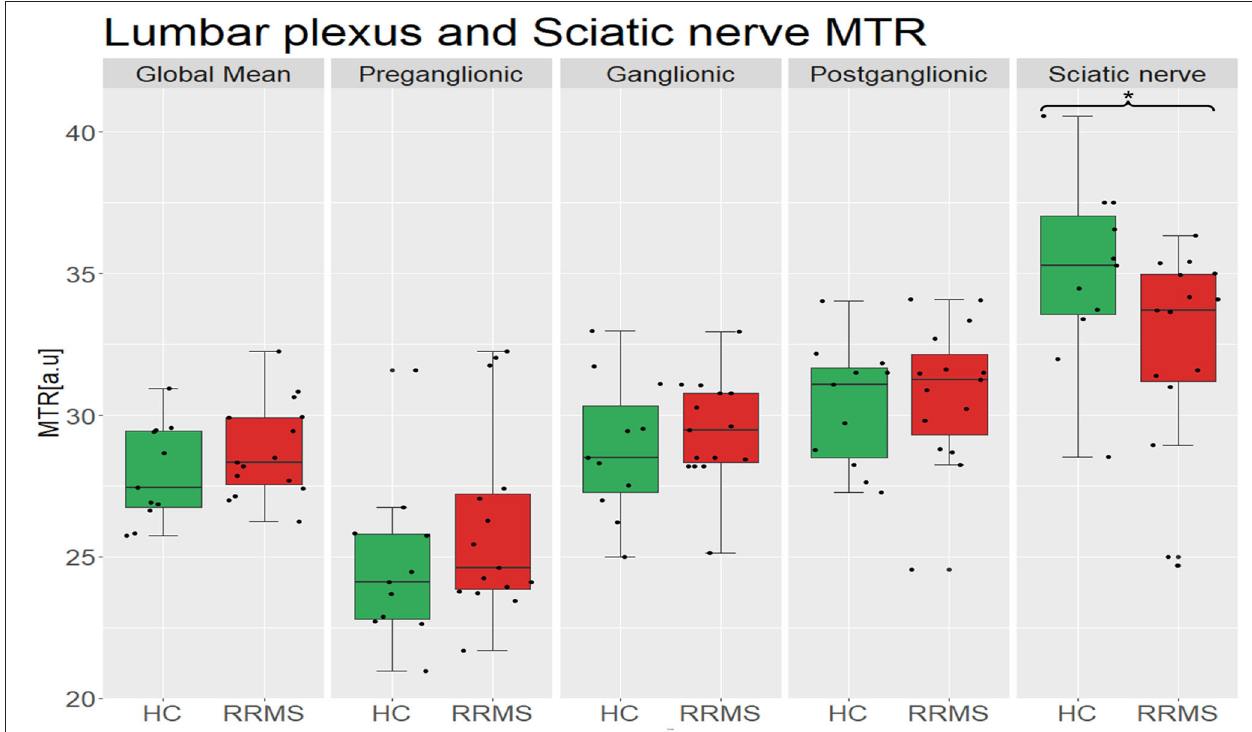
FIGURE 3 | Distribution of MTR values in the lumbar plexus (all lumbar segments combined i.e., global mean) and the sciatic nerve of healthy controls (green) and people with RRMS (red), and also results from separate measurements in the preganglionic, ganglionic and postganglionic regions; no statistically significant differences between the groups were identified in global or regional MTR measurements in the lumbar plexus, but the differences identified in the sciatic nerve were statistically significant ( p = 0.027). MTR, magnetisation transfer ratio; a.u., arbitrary units; HC, healthy controls; RRMS, relapsing-remitting multiple